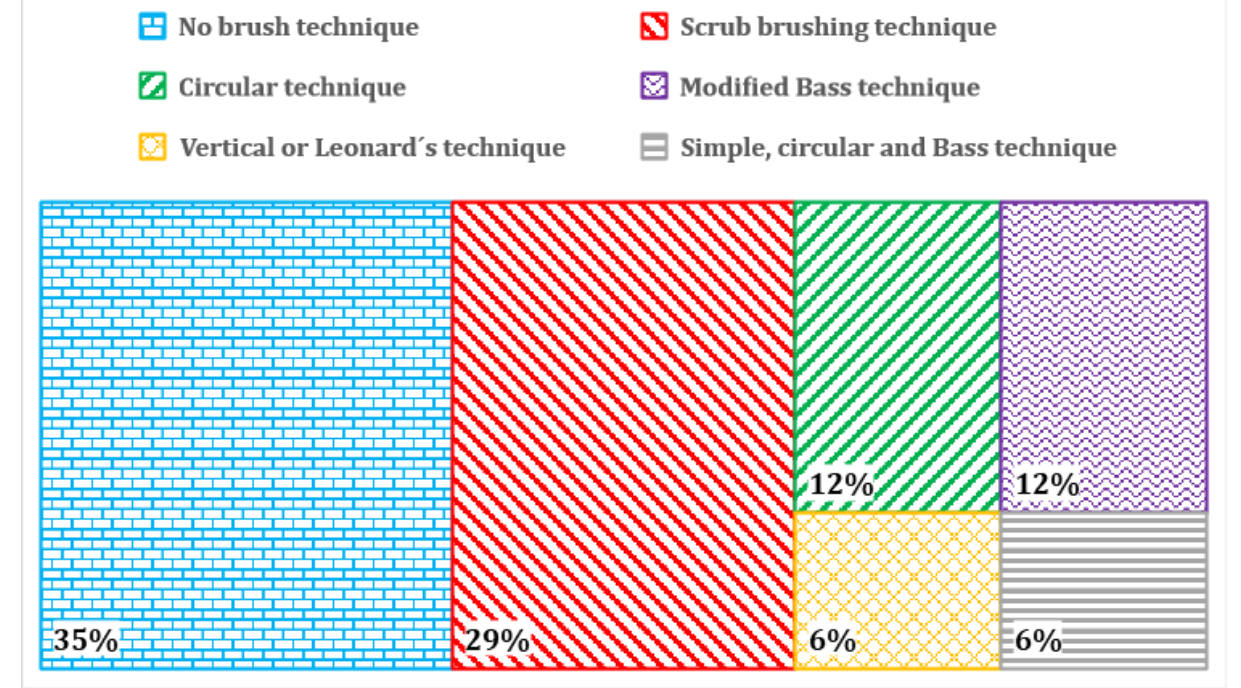
Figure 5. Brushing techniques used in the